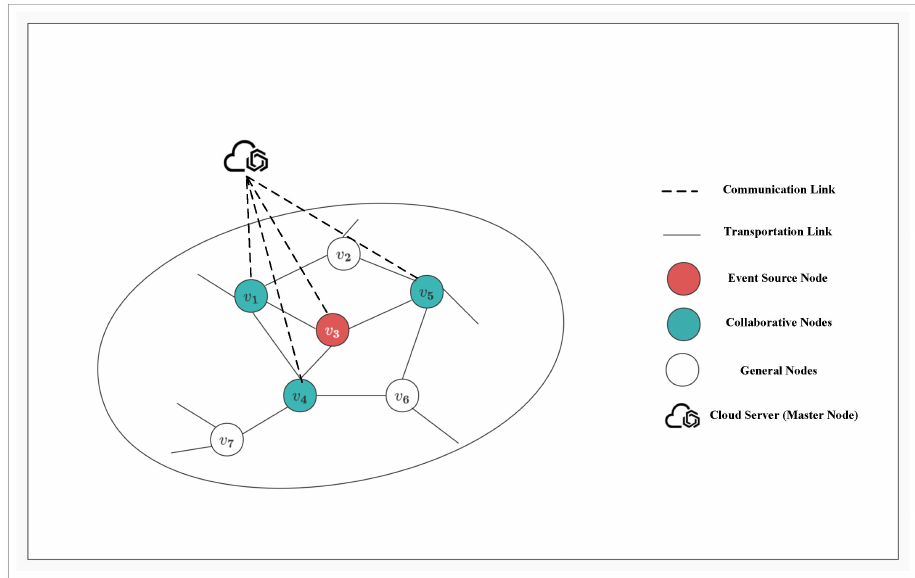
Figure 1. A road cooperative monitoring network based on